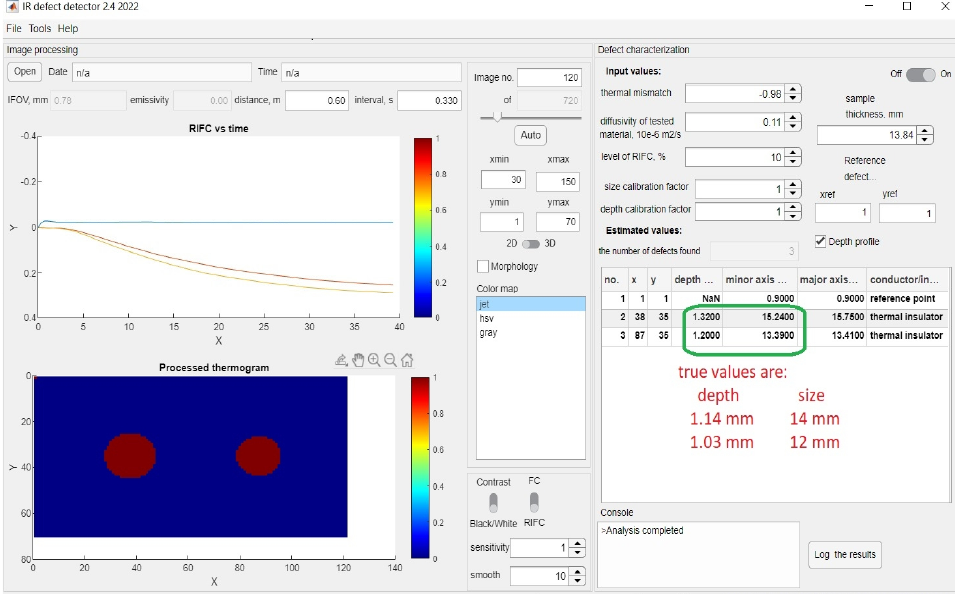
Figure 12. Screenshot of ‘IR defect detector’ GUI with two defects detected and parametrized.